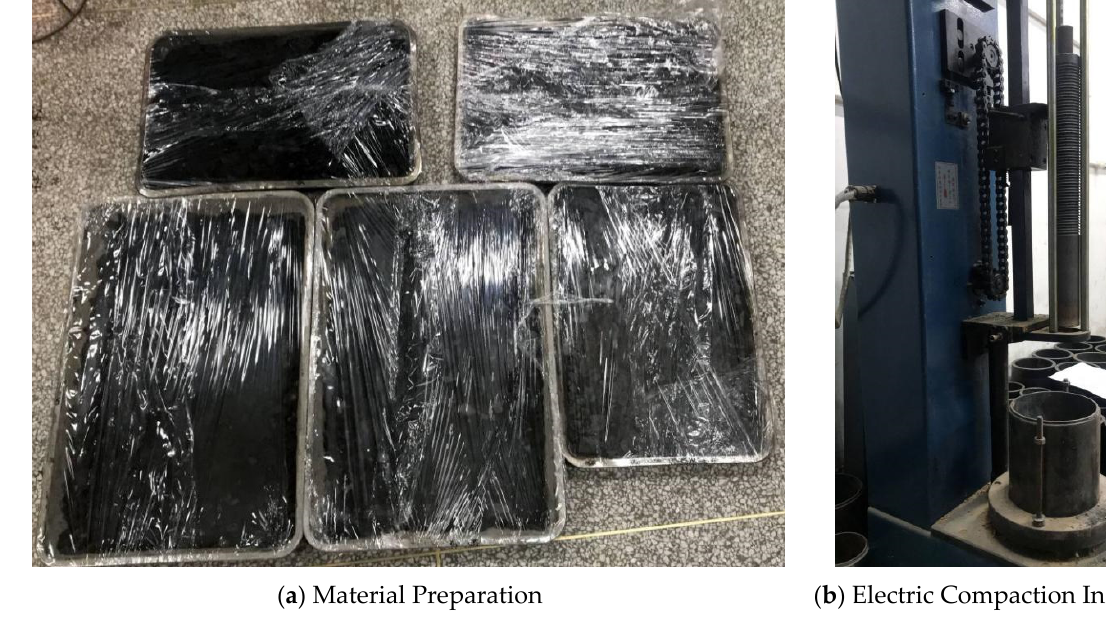
Figure 7. Compaction test.